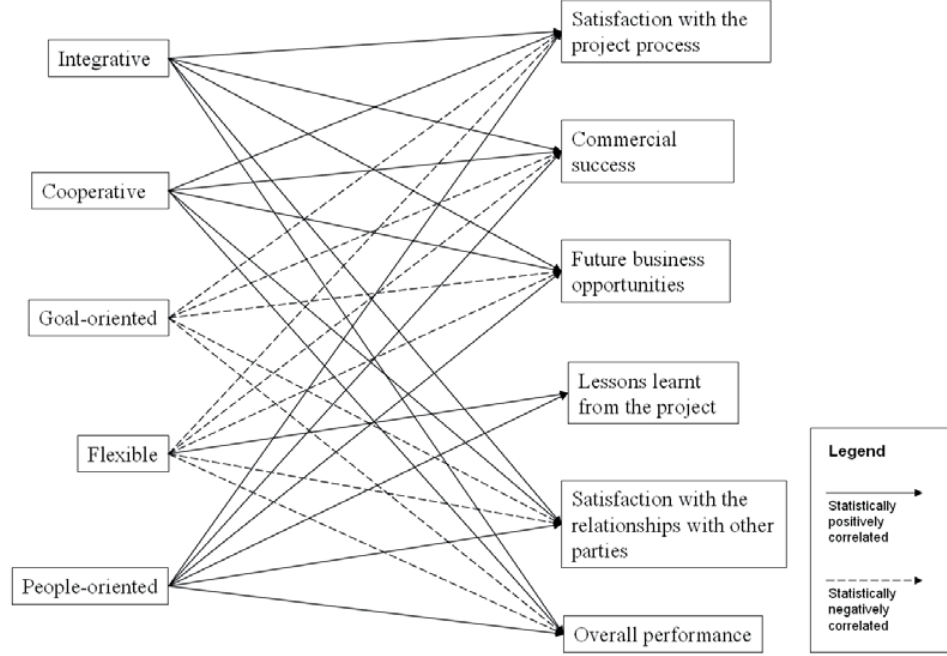
Figure 4: Perceived statistical relationships between project culture and project performance